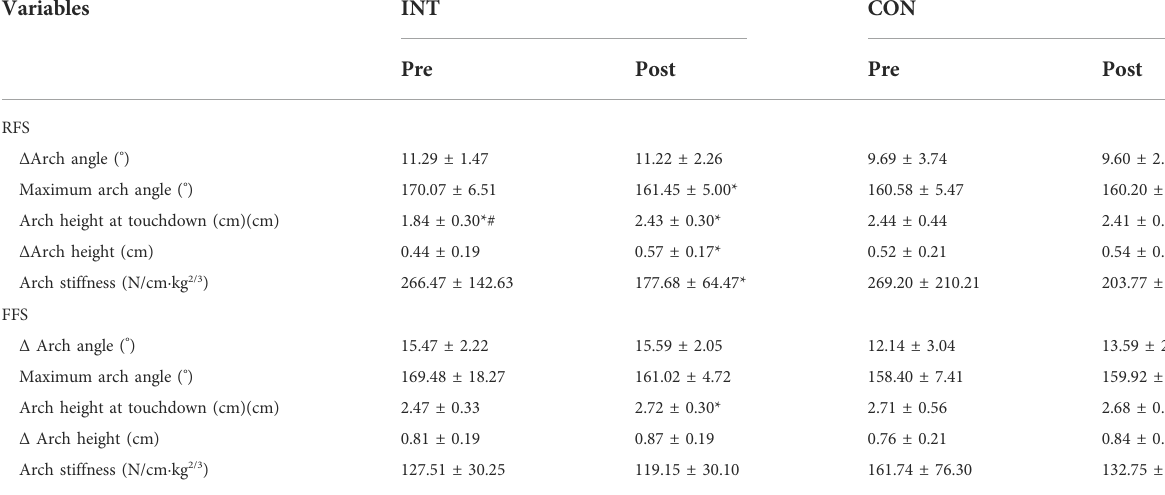
TABLE 5 Effects of a 12-week gait retraining program combined with foot core exercise on the arch kinematics.